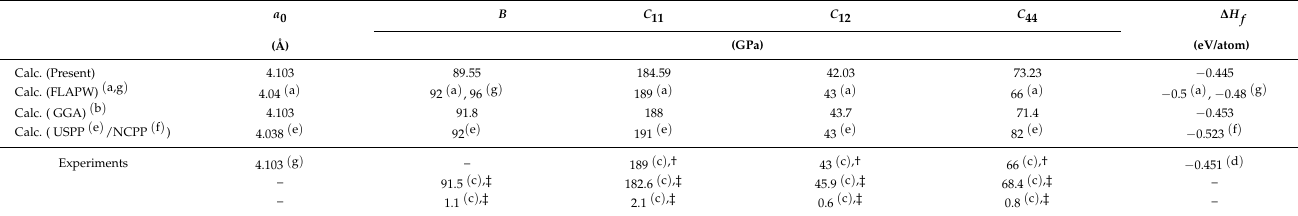
Table 1. Comparison between the calculated (at 0 K) and the experimental values of equilibrium lattice parameter a 0 , bulk modulus B M , elastic constants C 11 , C 12 , C 44 , and formation enthalpy ∆ H f of Al 3 Sc. The error bars for the experimental values ( , wherever available) of elastic constants are mentioned in the last row below the corresponding property. The dagger ± symbols † and ‡ for experimental values correspond to the data for single-crystal and polycrystalline Al 3 Sc in Ref. [58], where the Sc concentration was slightly above 25%.